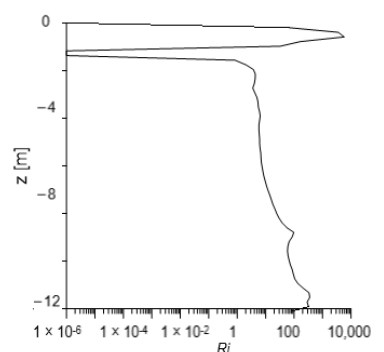
Figure 5. Profile of the Richardson number in the same numerical experiment.